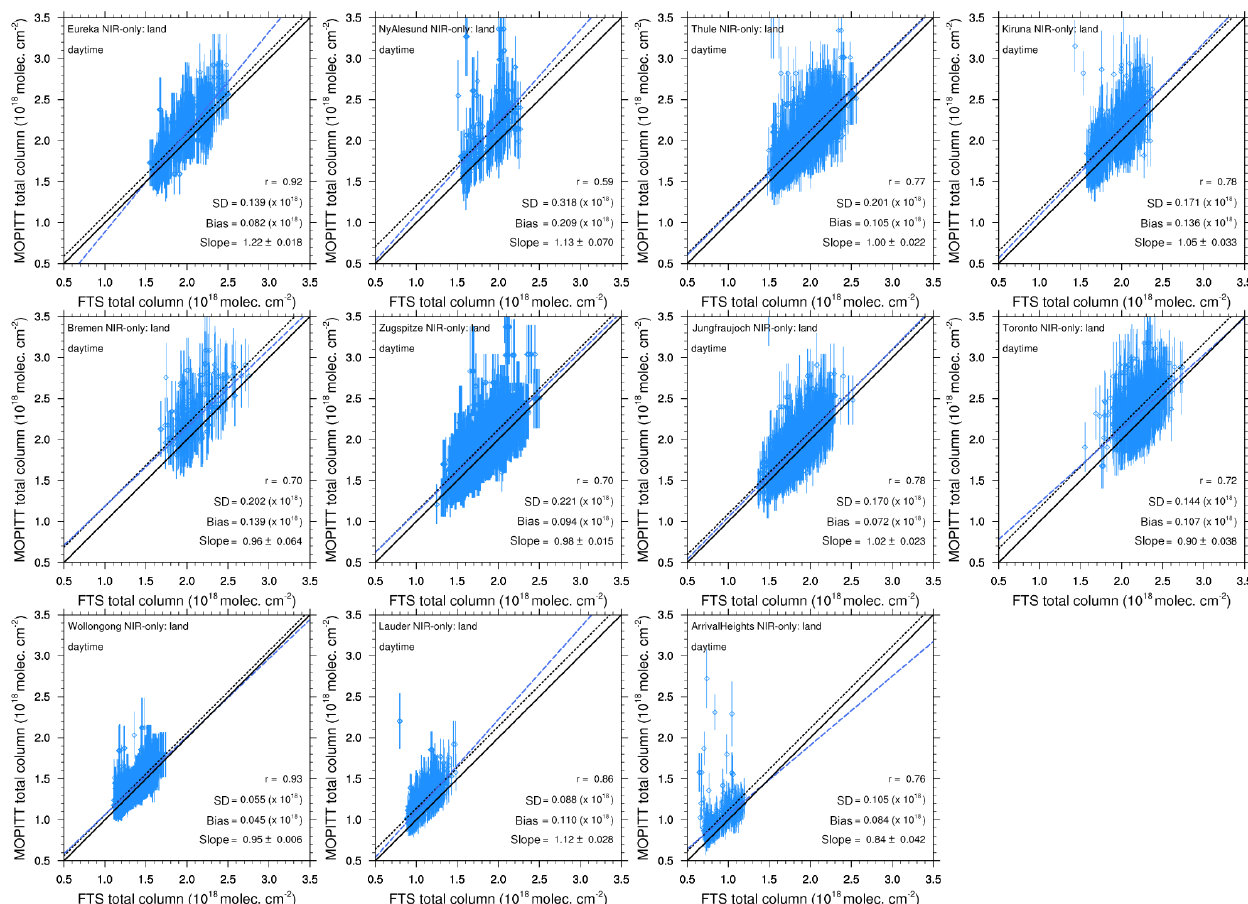
Figure A4. Correlation plot for V6 NIR-only product. The blue dashed line indicates correlation slope, the black dashed line indicates mean bias, and the solid black line is the 1 : 1 line for comparison. Error bars are the daily combined MOPITT error within a 1 ◦